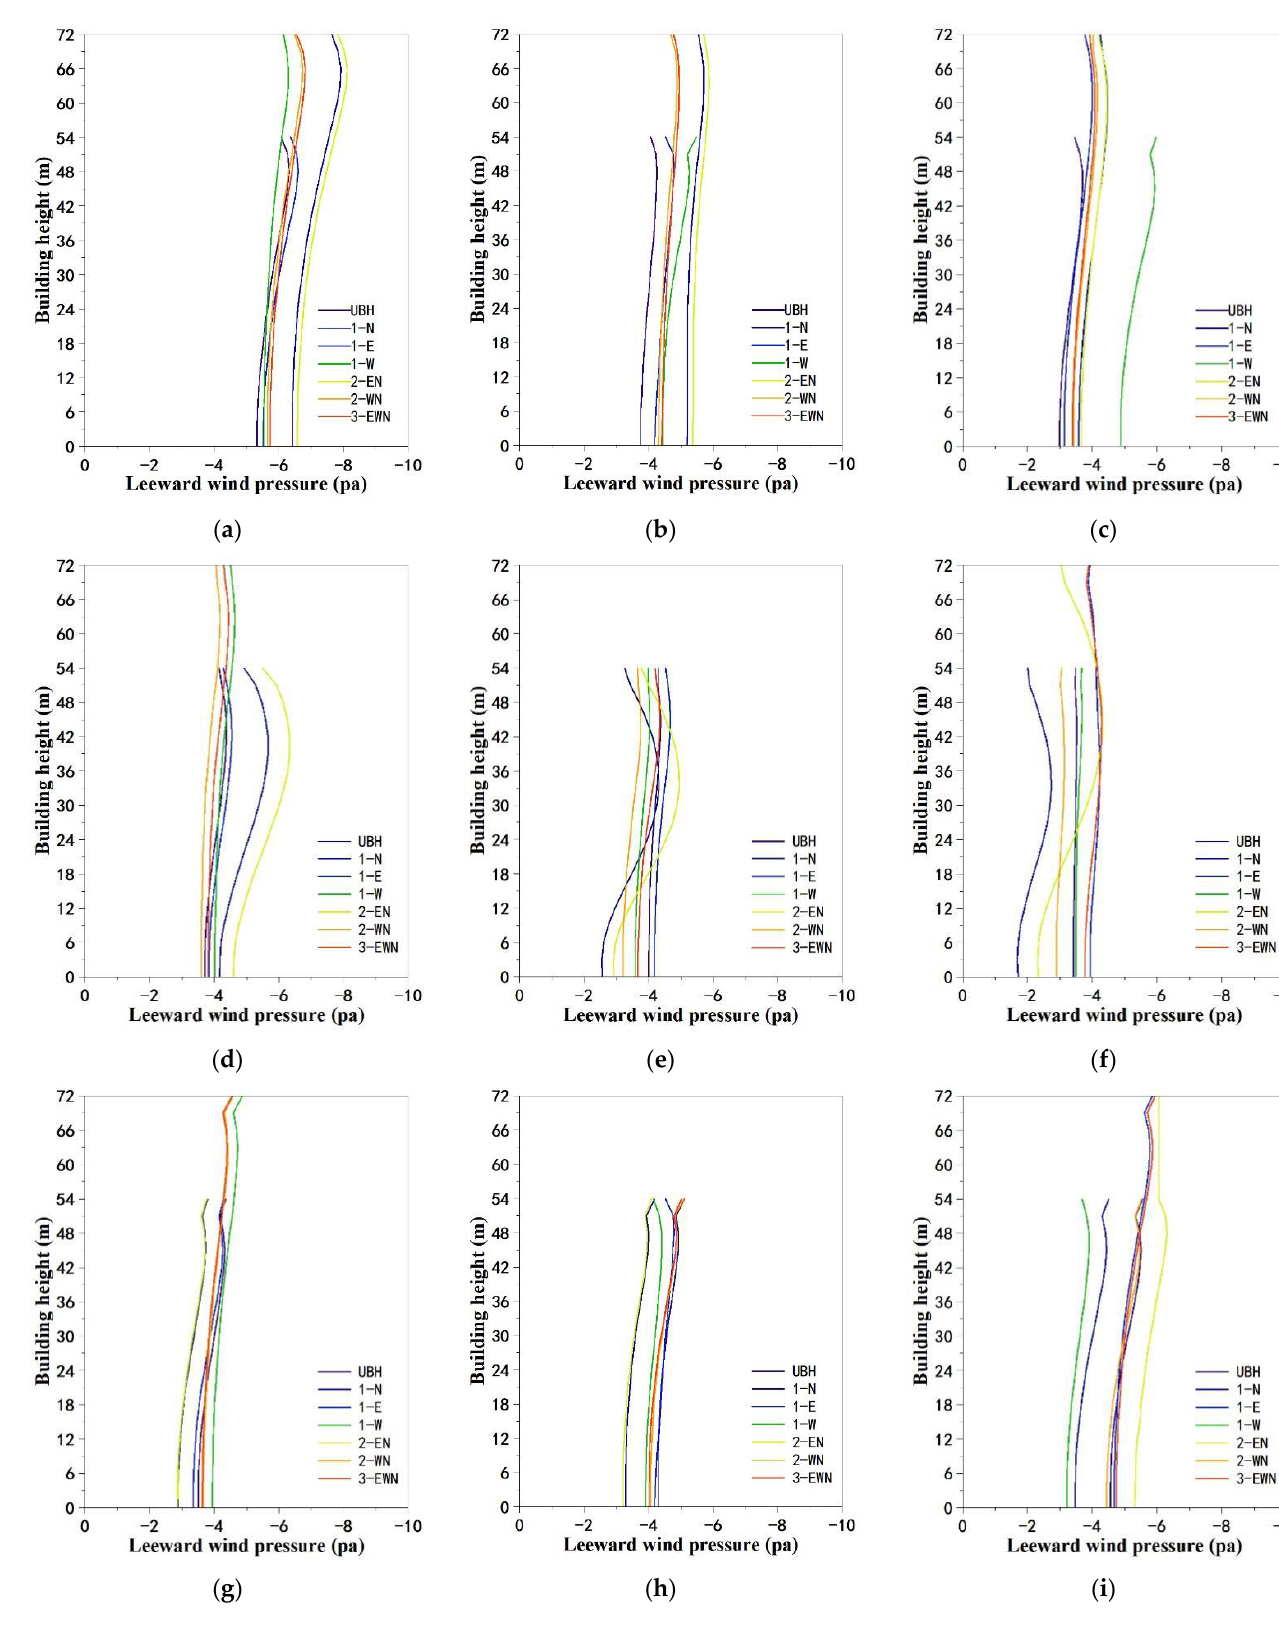
Figure A10. Wind pressure on the leeward side of single buildings under seven operating condi- tions; ( a ) building #1, ( b ) building #2, ( c ) building #3, ( d ) building #4, ( e ) building #5, ( f ) building #6,